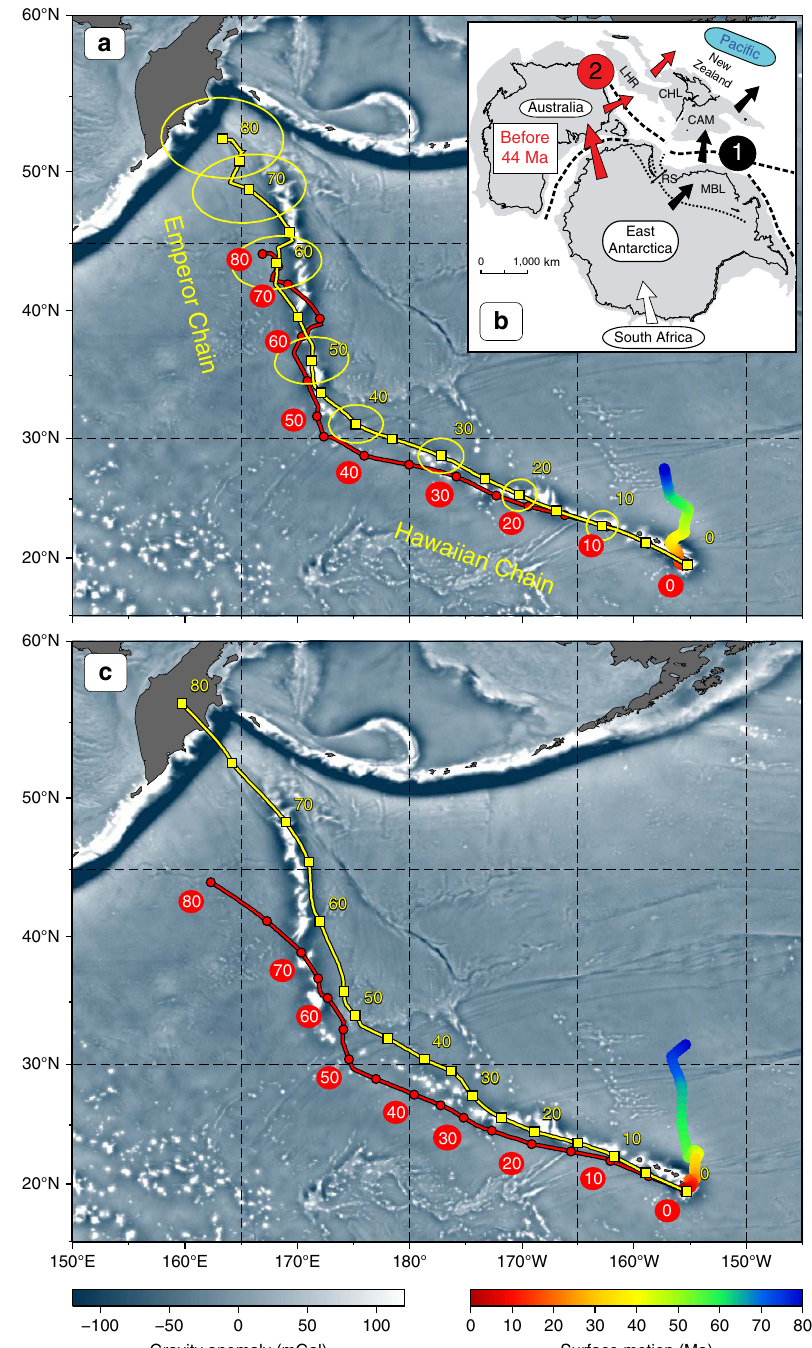
Figure 5 | Models of Hawaiian hotspot track and hotspot surface motion. ( a ) Model hotspot track (yellow thick line; yellow squares with uncertainty ellipses at 10Myr intervals) computed by combining the motion of the Pacific plate in the global moving hotspot reference frame 28 (using Model 2 plate circuits of panel b ) and the geodynamically modelled surface motion of the Hawaiian hotspot (rainbow-coloured swath; see ref. 28 for details). The red line shows the track that would be produced if the Hawaiian hotspot were fixed in the same reference frame, that is, reflects the plate motion alone. The difference between the yellow and red lines corresponds to the surface hotspot motion. ( b ) Two relative plate circuit models used for reconstructing relative motions between the Pacific plate and plates of the Indo-Atlantic hemisphere (for example, Africa). After chron 20 time (43.8Ma), Models 1 and 2 follow the same plate motion chain through East Antarctica and Marie Byrd Land 8 . LHR, Lord Howe rise; CHL, Challenger plateau; CAM, Campbell plateau; MBL, Marie Byrd Land; RS, Ross Sea. ( c ) Model tracks of the moving and fixed Hawaiian hotspot (yellow and red lines, respectively) calculated using the plate motion model of Hassan et al. 14 , which is based on the global moving hotspot reference frame of Torsvik et al. 55 but uses modified relative plate motions 56 . Similarly to a , the track for the moving hotspot (yellow line) combines the motion of the Pacific plate (traced by the red line) and the surface hotspot motion (rainbow-colored swath) from the preferred geodynamic model of ref. 14 (model M3). Because the hotspot drifts to the south in both models (plates a , c ), the bends in the modelled tracks (yellow lines) reflect the directional change of the Pacific motion at B 45–50Ma, whereas the southward hotspot drift contributes to produce a longer track, which is shifted to the north relative to the track that would be produced by a fixed hotspot (red lines). NATURE COMMUNICATIONS|8:15660|DOI: